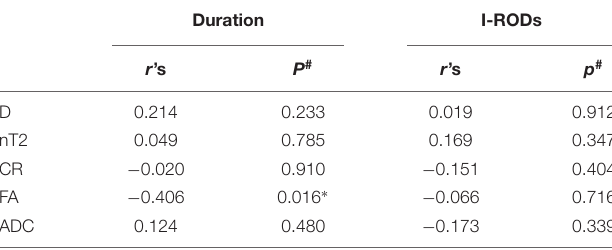
TABLE 5 | Correlations between clinical and MR parameters 5